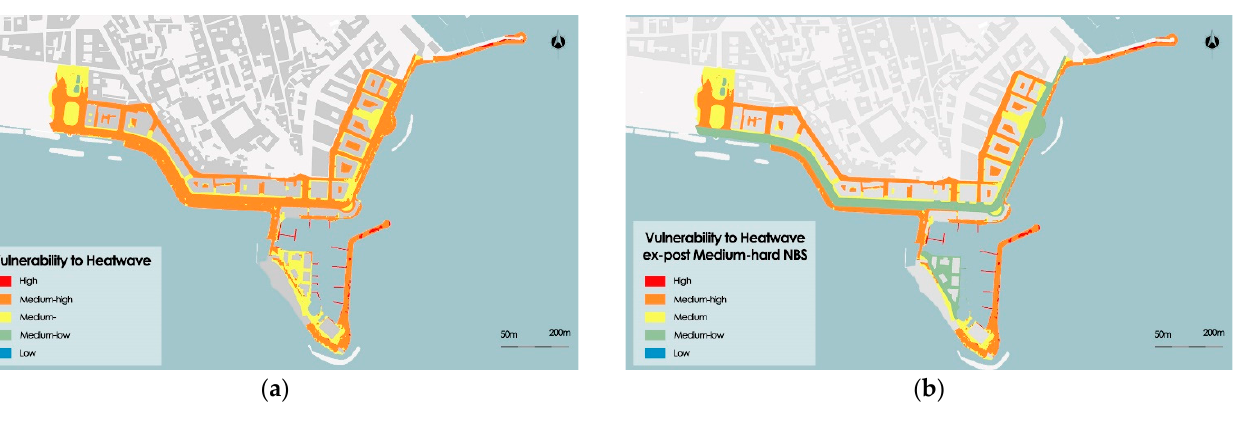
Figure 14. ( a ) Vulnerability to HW map ex-ante, medium-hard NBS application; ( b ) vulnerability to HW map ex-post, medium-hard NBS application.